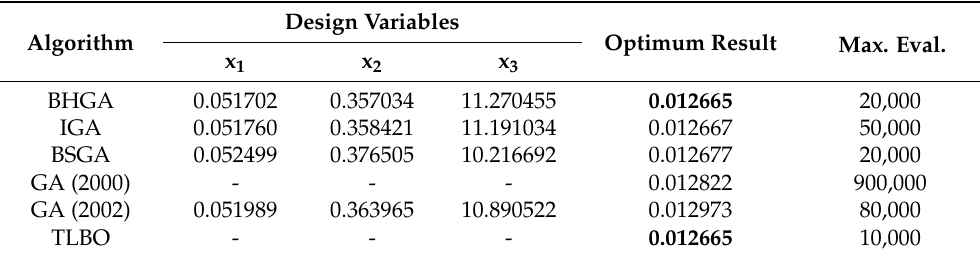
Table 7. Comparison of the BHGA optimization results with literature for the tension/compression spring problem.